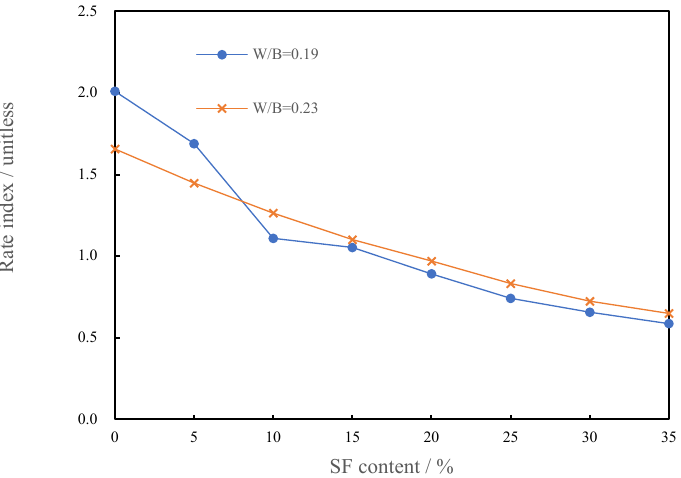
Figure 8. The relationship between the rate index and silica fume content.